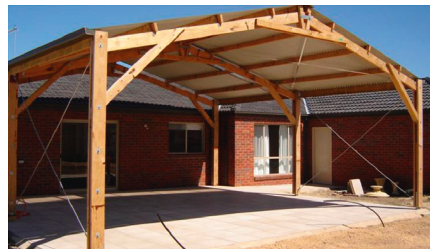
Figure 1: Typical timber portal frames.